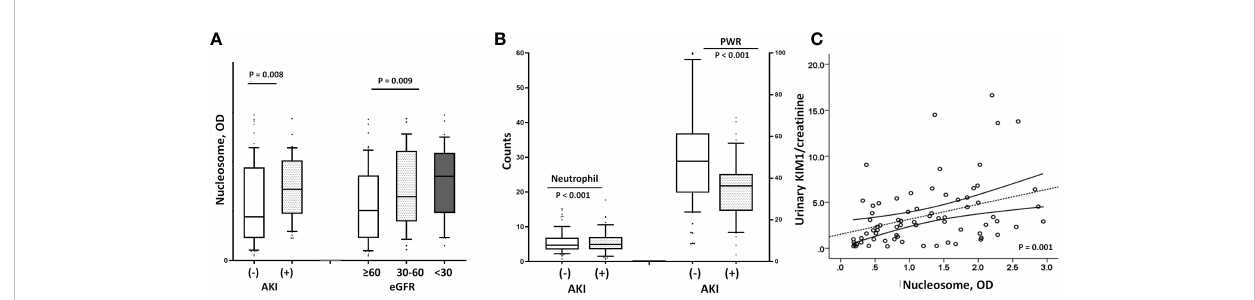
FIGURE 3 Relationship between renal dysfunction and nucleosome levels. (A) Patients with AKI had higher nucleosome levels than those without [median with IQR; 1.57 (1.05-1.81) vs. 0.87 (0.45-1.79), p=0.008], and the lower the eGFR, the higher the nucleosome level (p=0.009). (B) Similar to the fi ndings with circulating nucleosomes, patients with COVID-19 AKI had signi fi cantly higher peripheral neutrophil counts (9288 ± 5777 vs. 5979 ± 3948, p<0.001) and lower PWRs (20.8 ± 9.0 vs. 31.3 ± 16.2, p<0.001) than those without AKI. (C) Urinary marker of AKI, the urinary KIM1/creatinine ratio also correlated signi fi cantly with higher nucleosome levels (r=0.368, p=0.001). AKI, acute kidney injury; eGFR, estimated glomerular fi ltration rate; KIM1/creatinine, kidney injury molecule 1/creatinine; BNP, B-type natriuretic